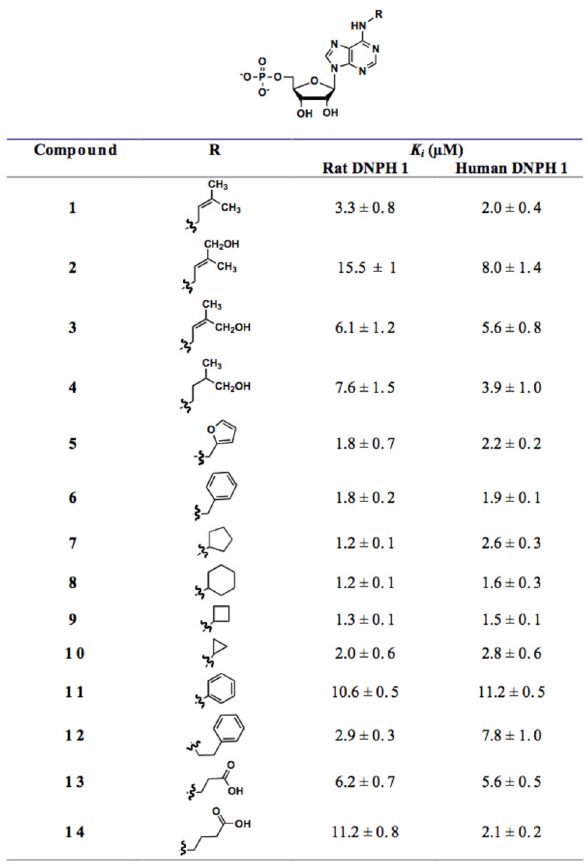
of human and rat d